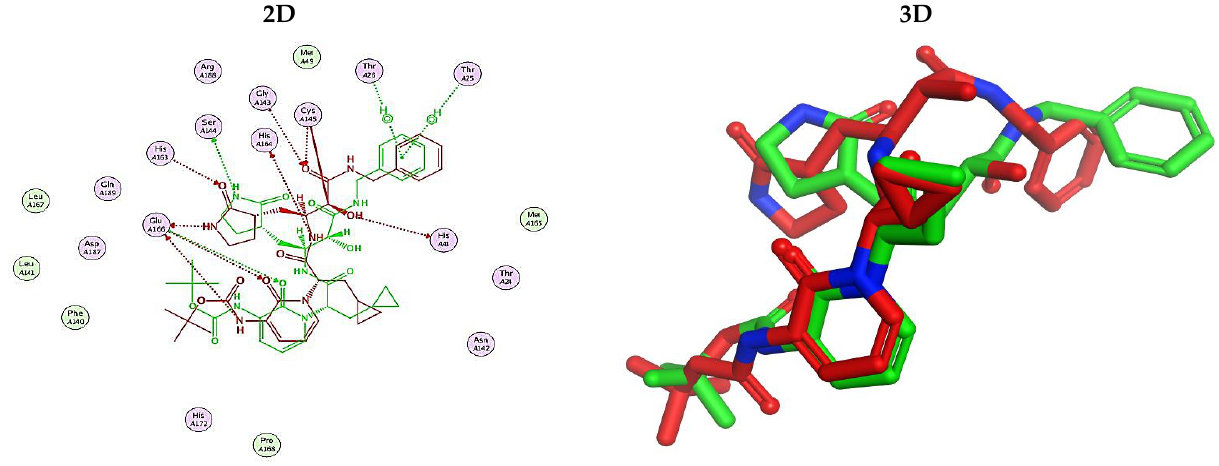
Figure 7. Superimposition of the redocked O6K inhibitor (green) over its native one (red).